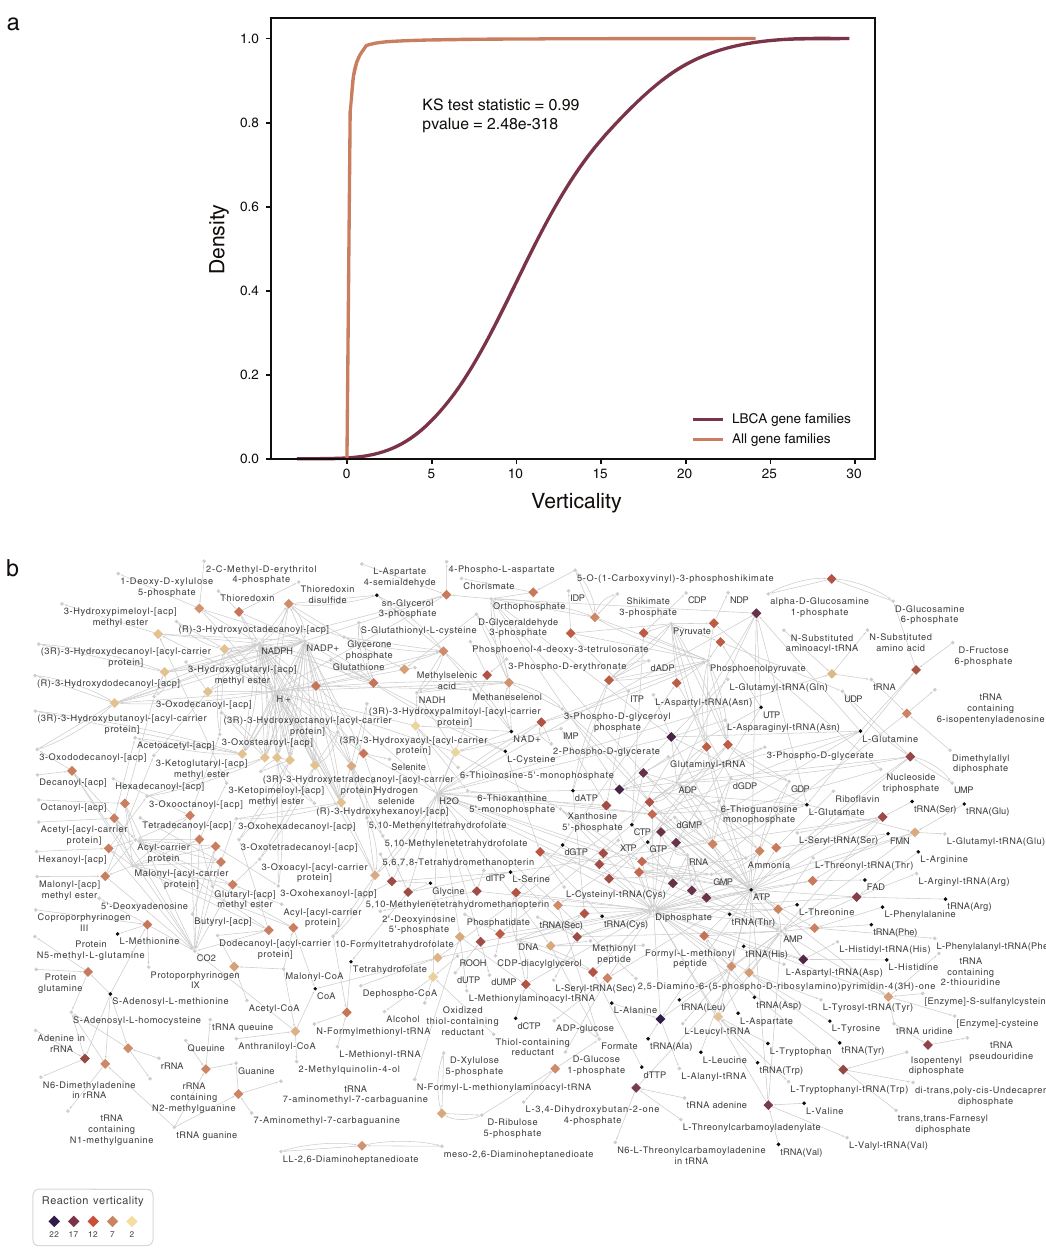
Fig. 4 Analysis of verticality for LBCA gene families. a Verticality for all prokaryotic gene families (light brown) and for LBCA gene families (dark brown) and Kolmogorov – Smirnov statistics between the two distributions. b LBCA metabolic network annotated with verticality value for each reaction